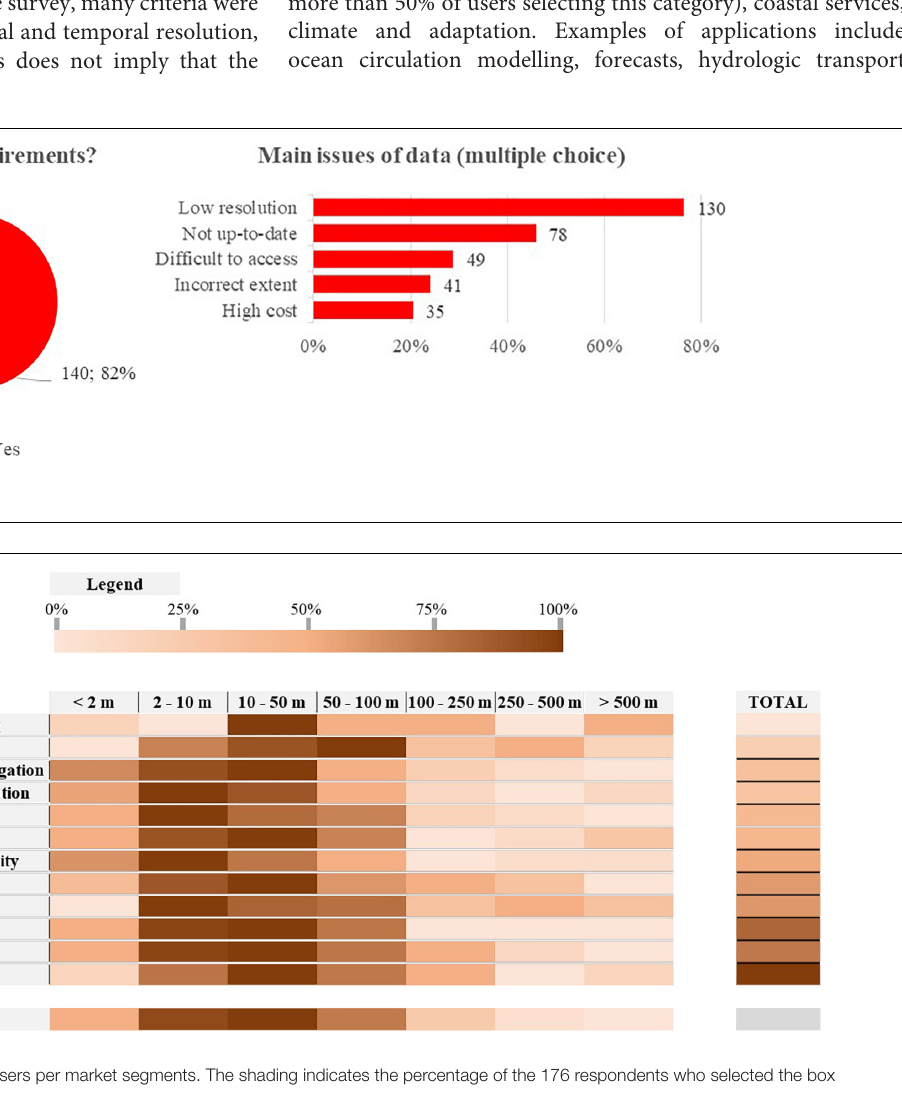
Frontiers in Marine Science |